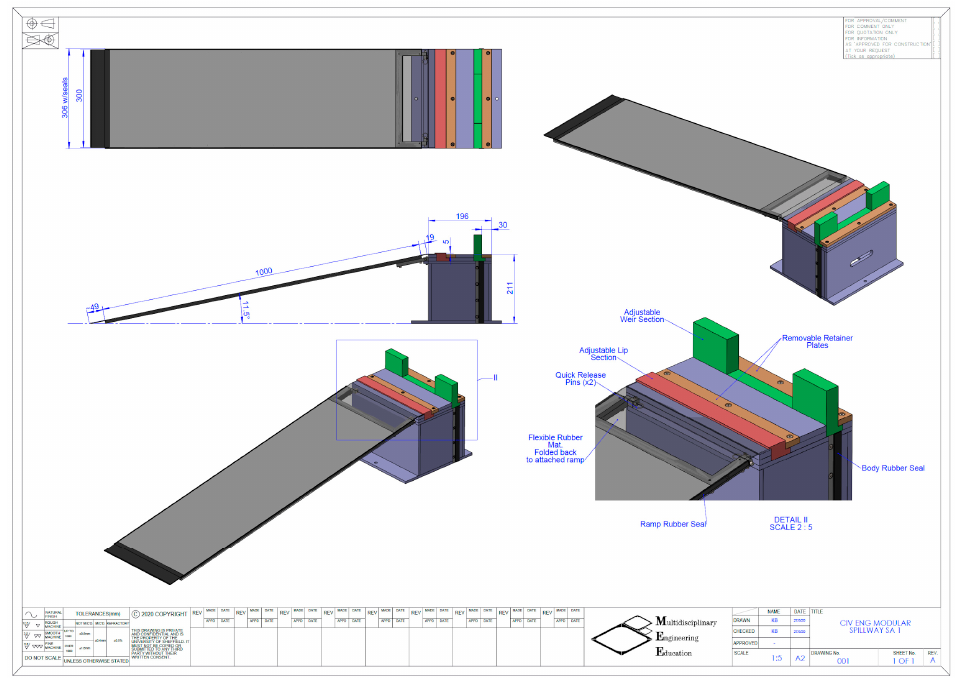
Figure 4. Bespoke rig for teaching spillway design.